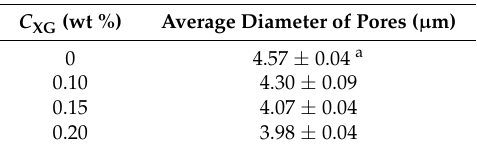
Table 3. Average diameter of the pores of gels of C NaCAS 3 wt %; C XG variable; R 0.5 and T 25 ◦